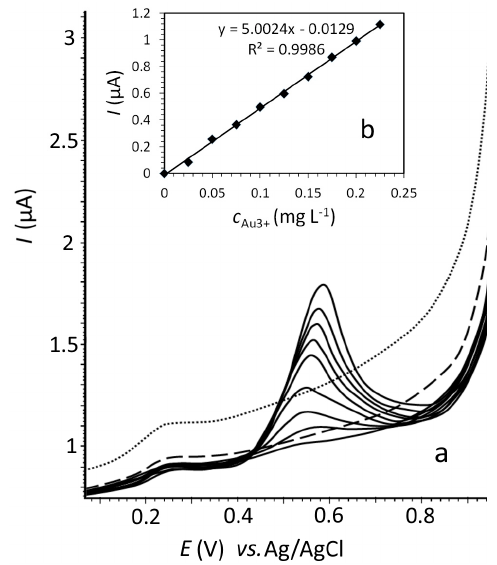
Figure 7. Anodic current–voltage curves ( a ) and calibration dependences ( b ) of gold determination from the surface of GE modified by ε -Caprolactam. Experimental conditions: medium of 1 mol L − 1 HCl, E e = − 0.7 V, t e = 120 s, v = 0.06 V s − 1 ; c Au3+ (mg L − 1 ): (1) blank, (2) 20 µ L of 1% ε -Caprolactam, (3) 0.025, (4) 0.05, (5) 0.075, (6) 0.1, (7) 0.125, (8) 0.15, (9) 0.175, (10) 0.2, and (11) 0.225.